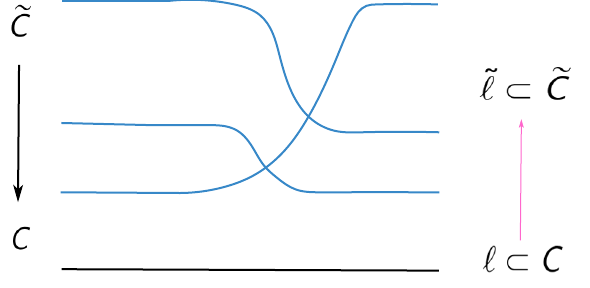
Figure 4 . Here we show the Seiberg-Witten curve e C as a branched covering over the Riemann surface C associated with a 4d class S theory. 1 / 2 -BPS UV line defects correspond to topologically nontrivial loops ‘ ⊂ C while 1 / 2 -BPS IR line defects are represented by loops ˜ ‘ ⊂ e C . The classical limit ( q = − 1 ) of the quantum UV-IR map is a procedure which takes ‘ ⊂ C and uplifts it to combinations of ˜ ‘ ⊂ e C